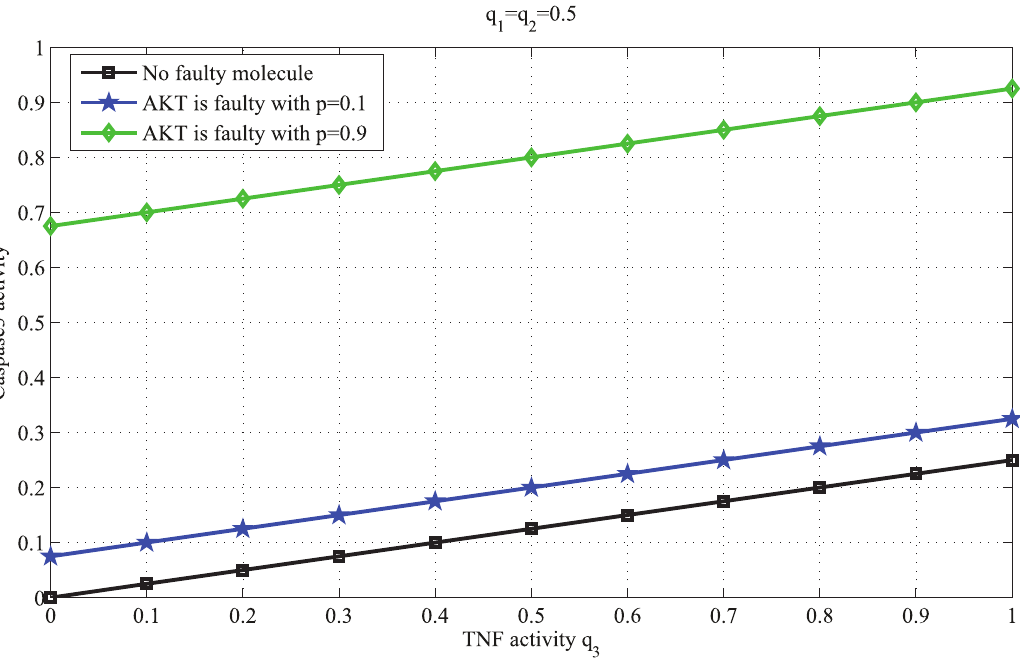
Figure 4. Caspase3 activity in terms of the TNF activity q 3 , when AKT is faulty. In this figure the activity of TNF changes from 0 to 1, whereas the activities of EGF and insulin are the same, q 1 ~ q 2 ~ 0 : 5 . As a baseline, the black graph shows the output activity when there is no faulty molecule. When AKT’s fault probability is small, p ~ 0 : 1 , the output activity slightly increases (blue graph). However, when AKT’s fault probability is large, p ~ 0 : 9 , the output activity increases significantly (green graph).